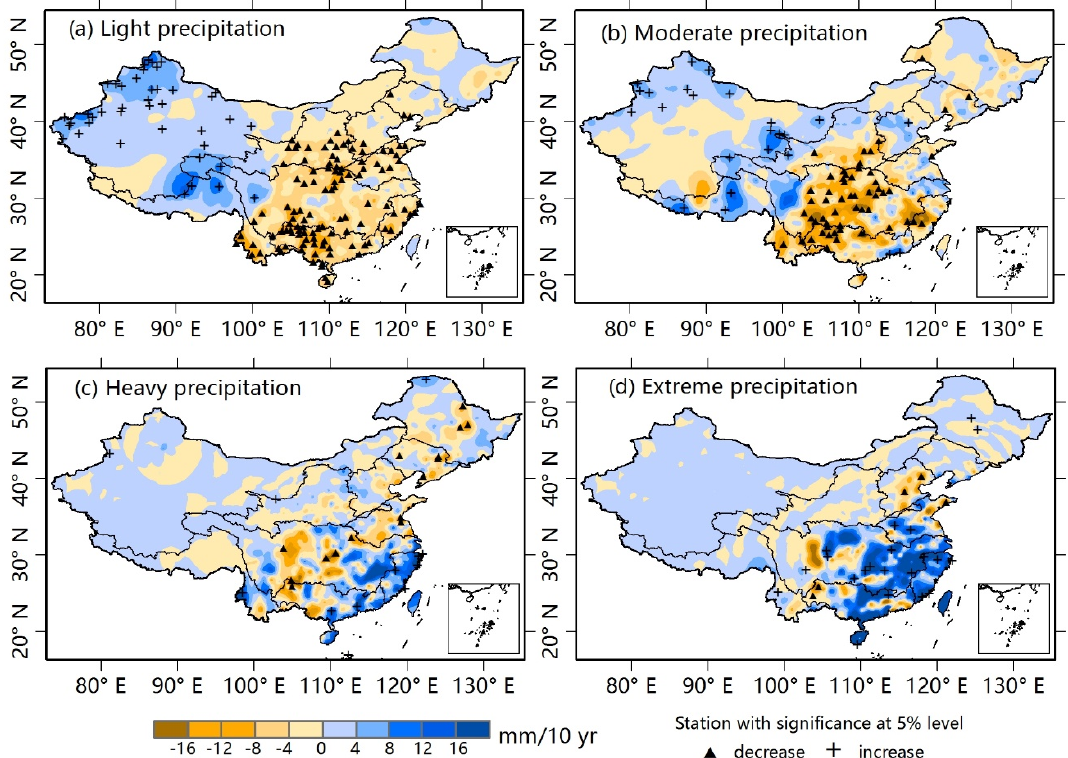
Figure 3. Trends in precipitation of each category for 1960–2013. ( a ) Light precipitation, ( b ) moderate precipitation, ( c ) heavy precipitation, and ( d ) extreme